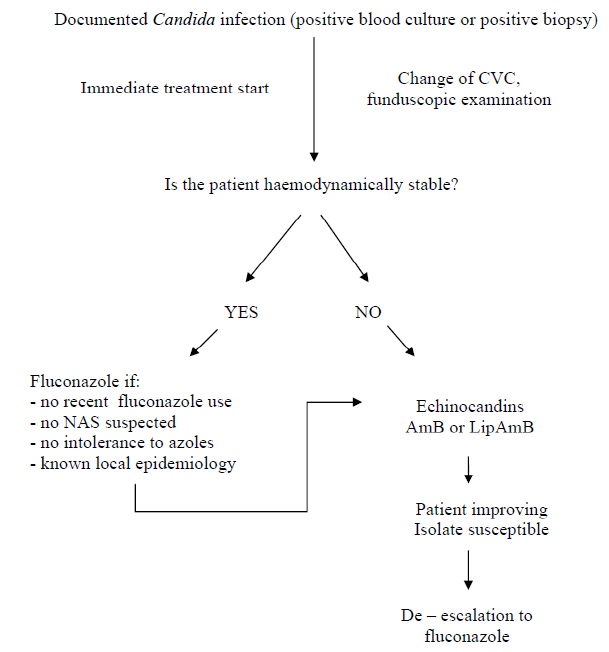
Figure 1. Suggested treatment algorithm for the ICU patient with invasive candidiasis (NAS: non- albicans species, CVC: central venous catheter, AmB: amphotericin B, LipAmB: liposomal amphotericin